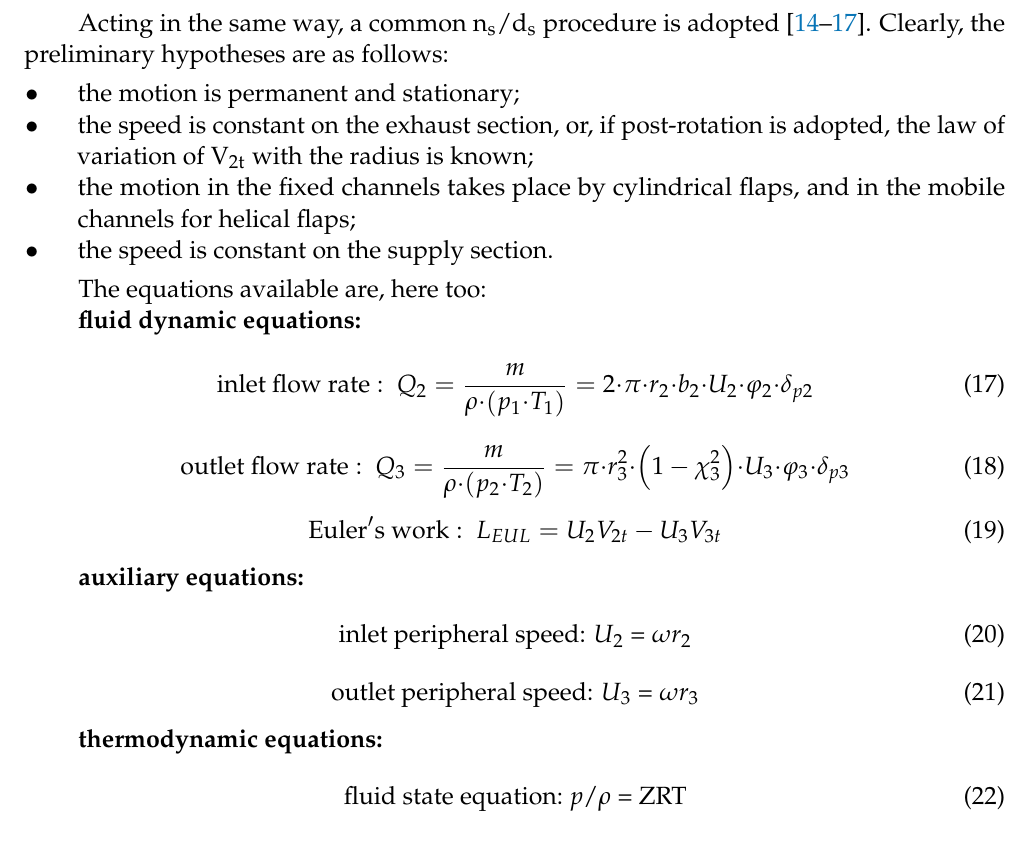
Figure 5. Inlet forward radial turbine reference layout.